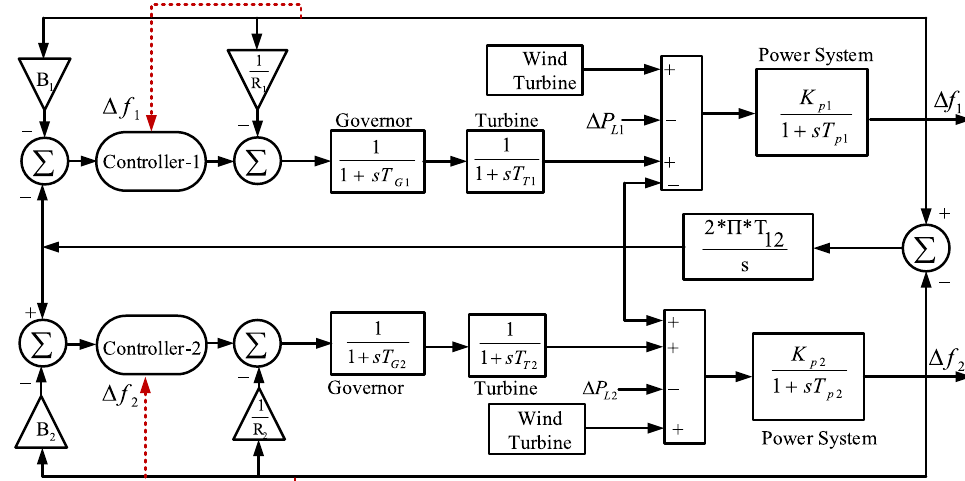
Fig. 1 Schematic Block diagram of two area interconnected system with wind